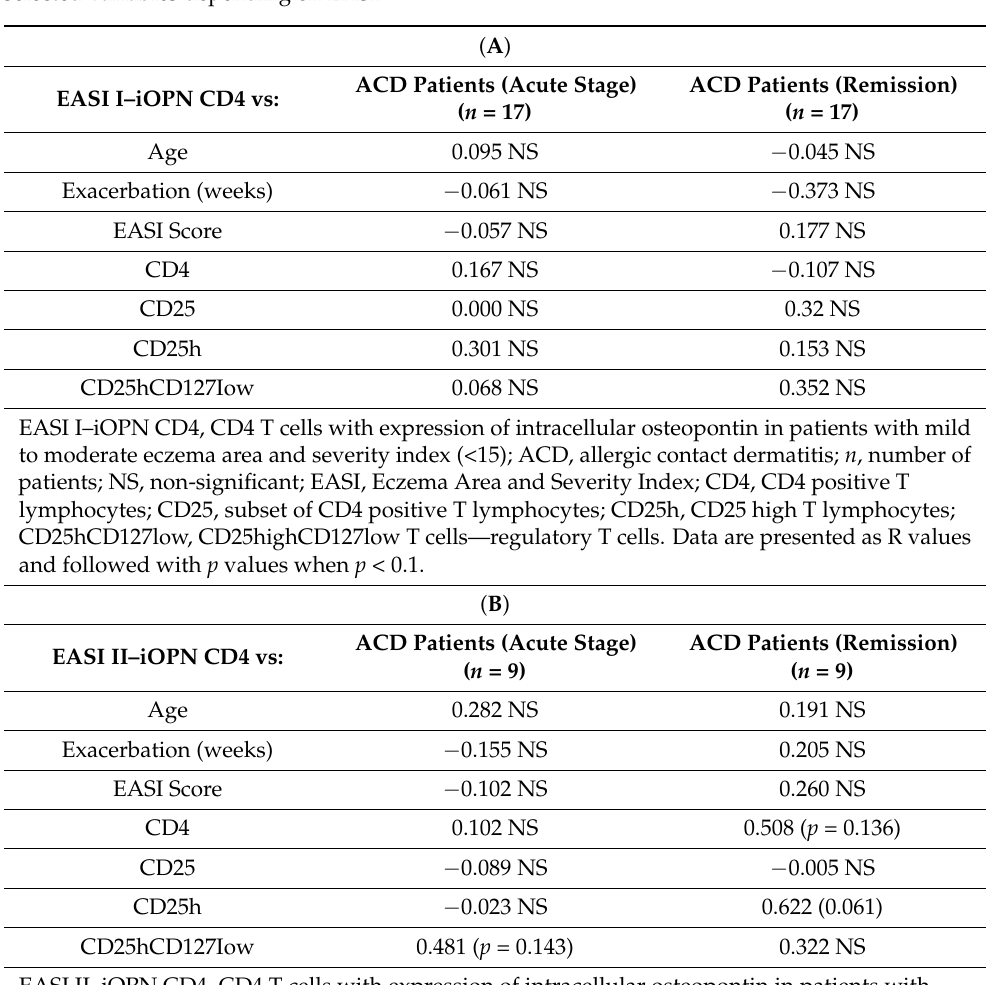
Table 3. ( A , B ). Correlation between percentage of iOPN CD subpopulations in ACD patients and selected variables depending on